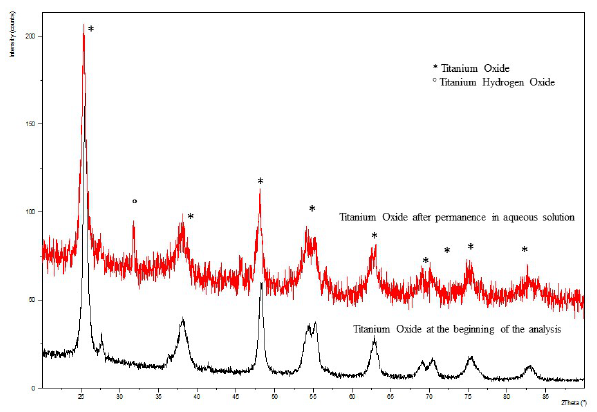
Figure 6: X-Ray diffraction patterns for the starting TiO 2 and following the extraction from the physio- logical solution after 14 days